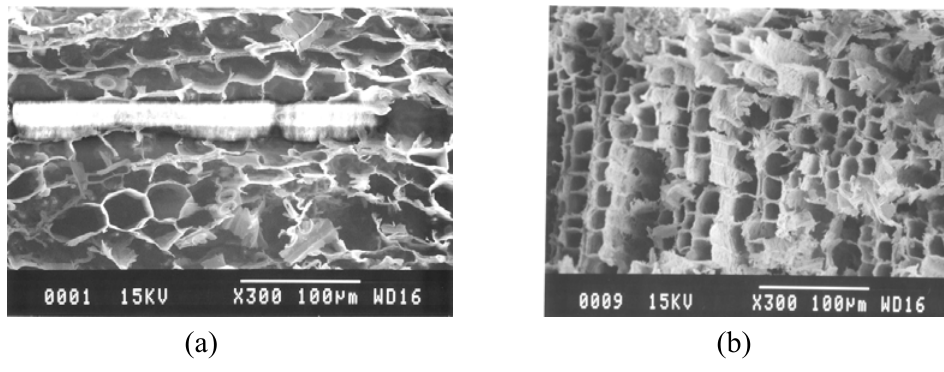
Figure 2. SEM micrographs of the porous Ba-ferrite sintered at: (a) 800 °C and (b) 1000